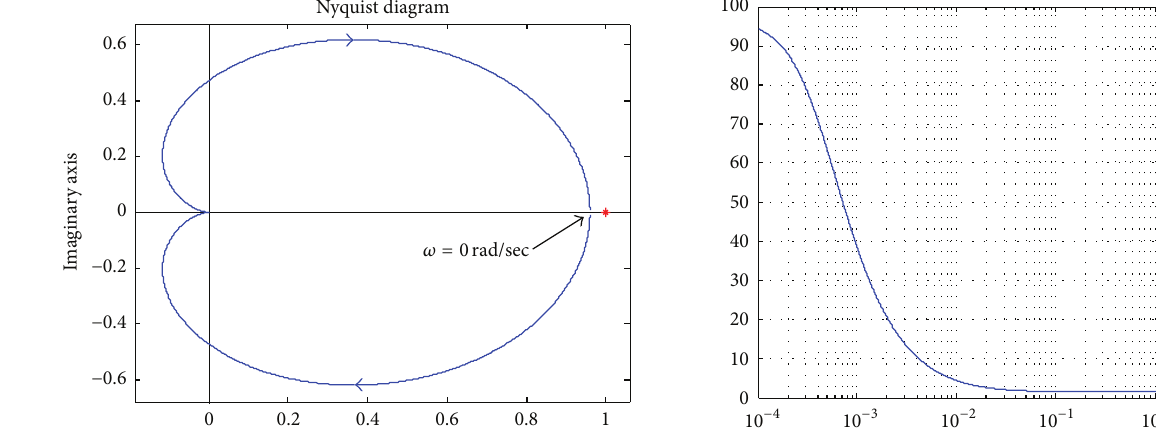
Figure 10: Condition number 𝜅 2 (𝑗𝜔) (Case 2 ).